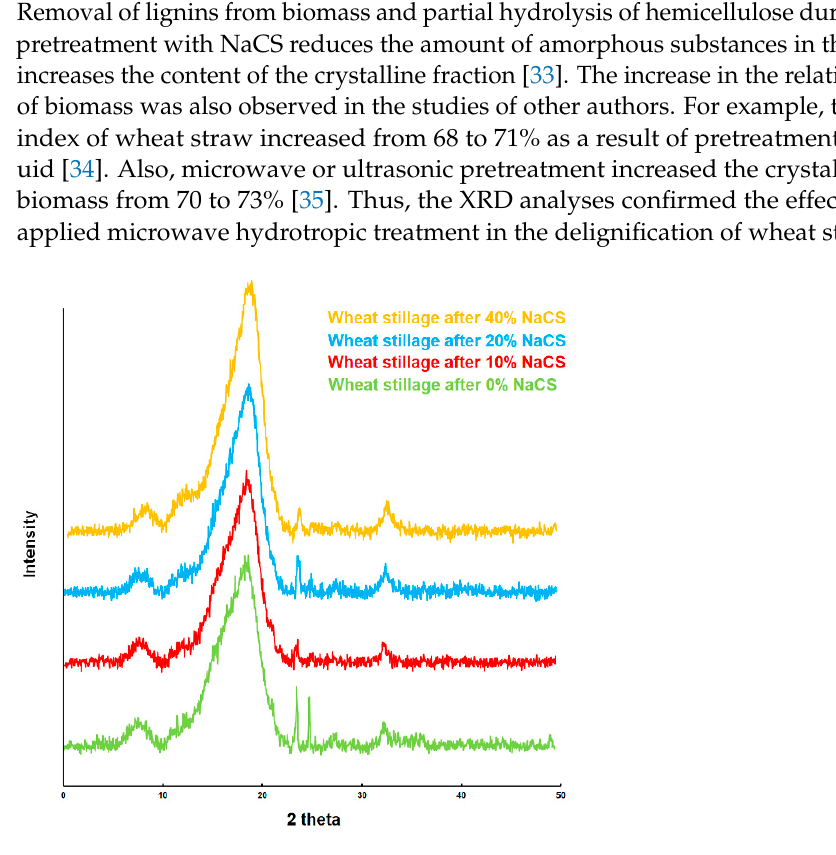
Figure 1. X-ray diffractograms of the wheat stillage samples after microwave-assisted hydrotropic pretreatment.